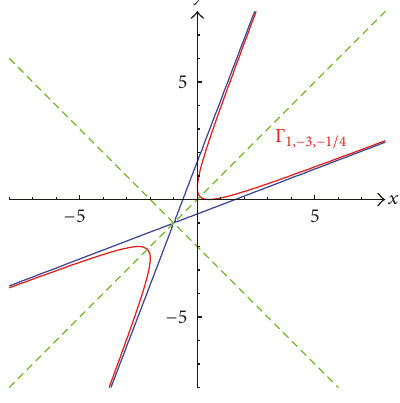
Figure 18: The plot of Γ 1,𝜌,−1/4 , where 𝜌 = −3